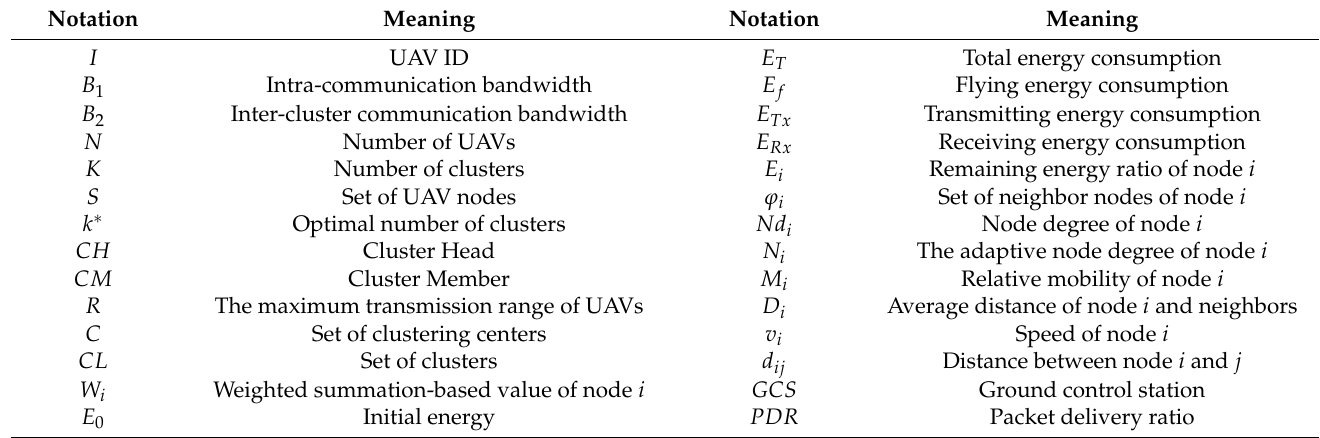
Table 2. Notations in this